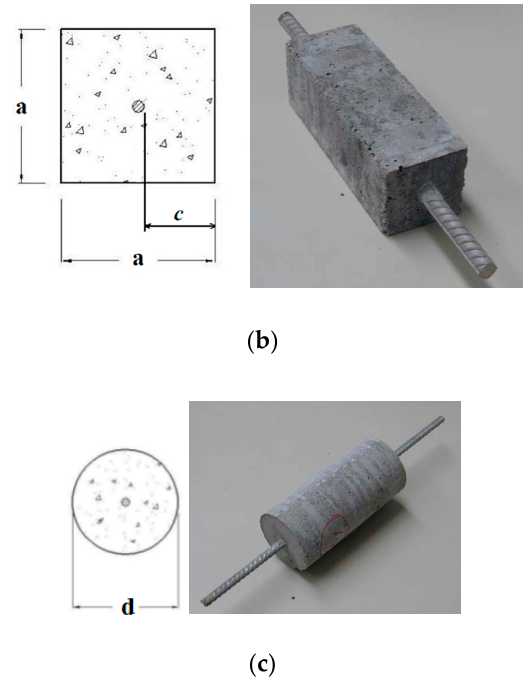
Figure 3. Prismatic concrete specimen: ( a ) longitudinal view; ( b ) square base shape; ( c ) circular base shape.